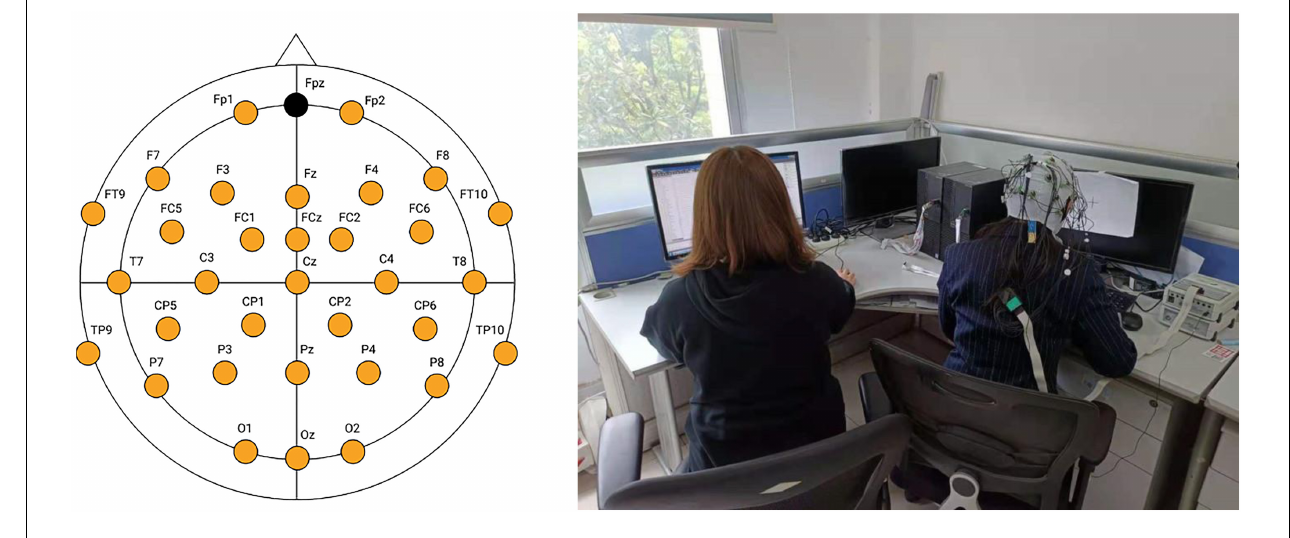
FIGURE 3 | EEG electrode positions (left) and experiment site (right).